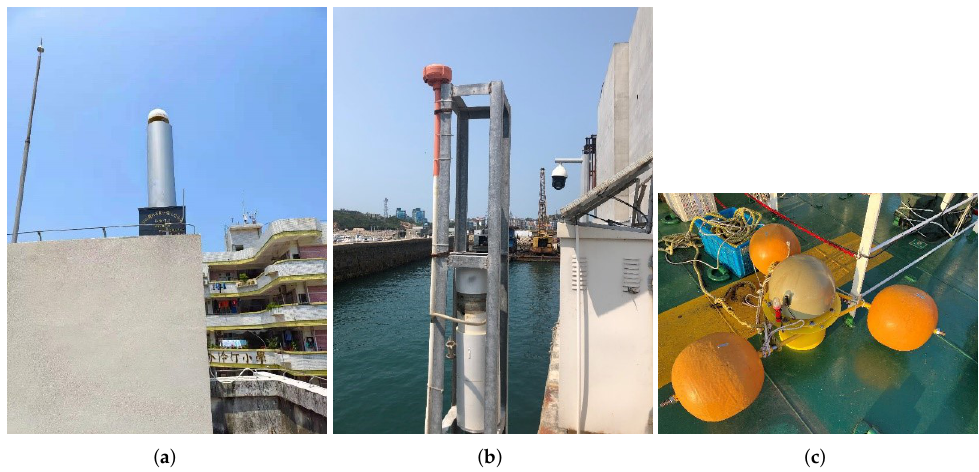
Figure 6. ( a ) GNSS antenna and receiver in Wailingding Island; ( b ) the acoustic tide-gauge in Wailingding Island; and ( c ) the GNSS buoy to be deployed in the near